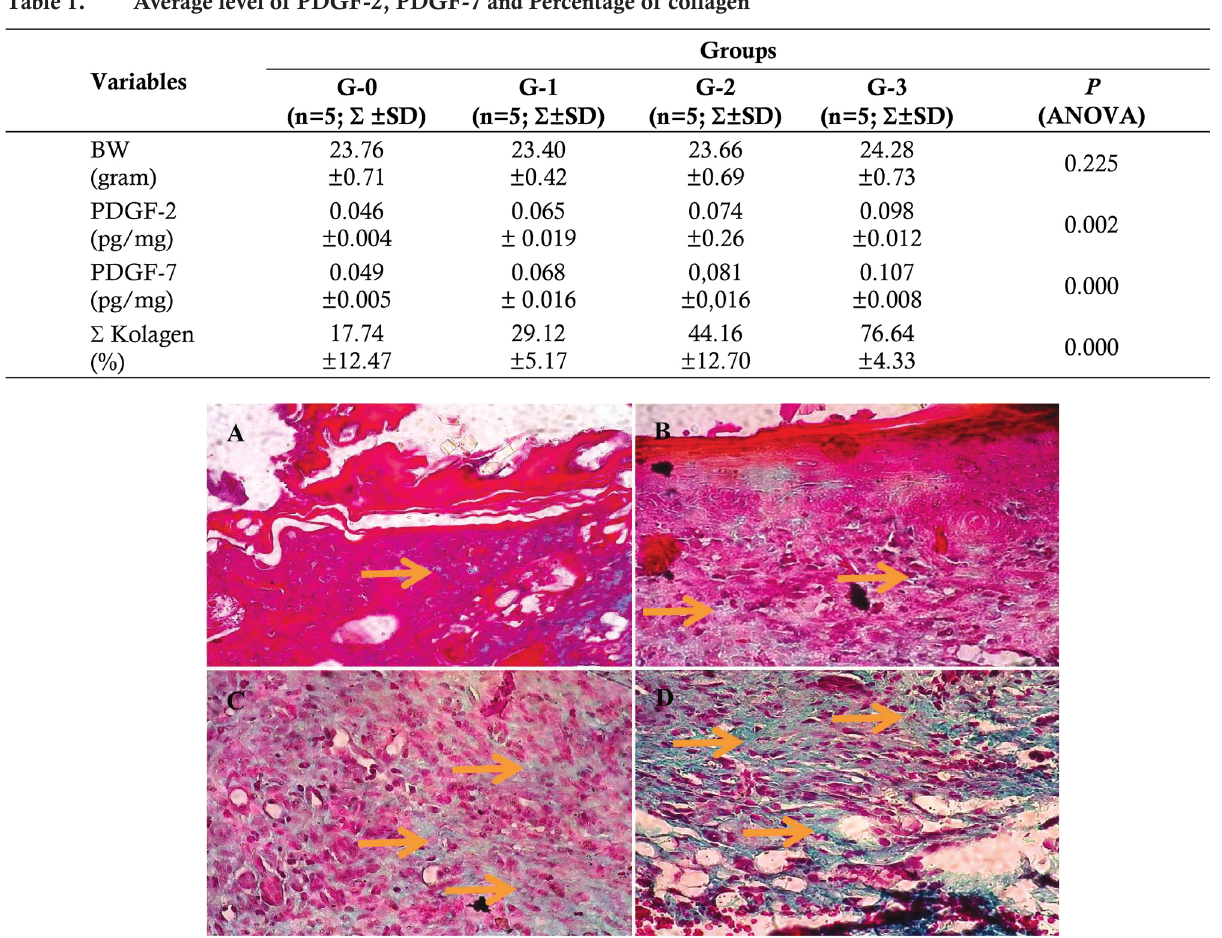
Stem Cell Mesenchymal Injection Increases Platelet-Derived Growth Factors Level and Percentage ... Table 1.